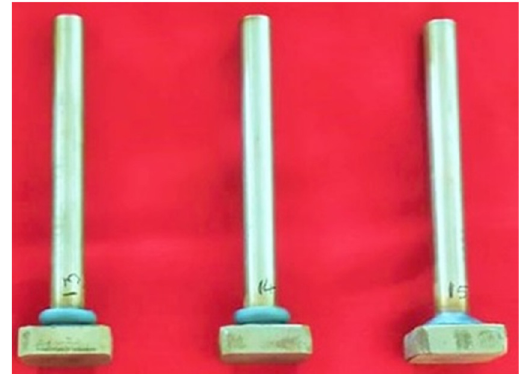
Figure 6: Photograph of rod - to - plate joints of AISI 431 steel – AISI 1018 steel.